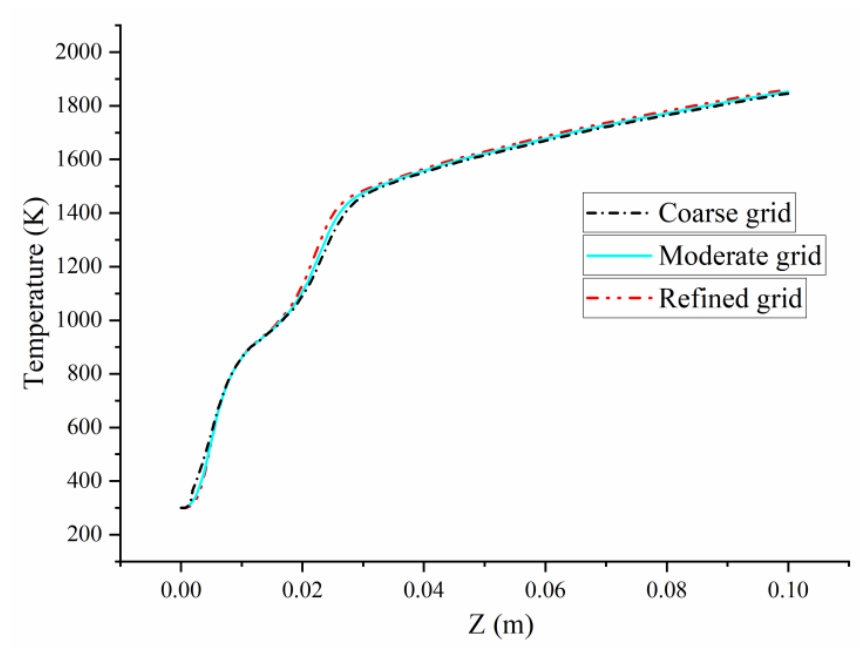
Figure 4. Centerline mean temperature profiles with different mesh densities.